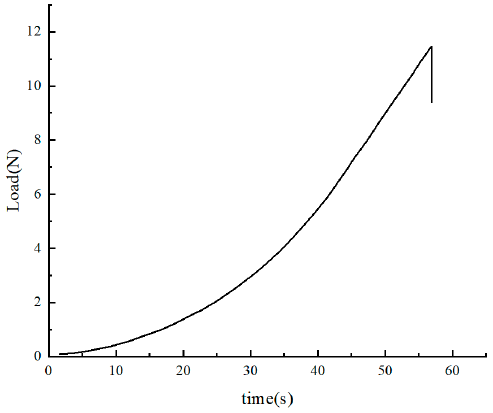
Figure 21. Typical stem–leaf separation force–time curve.